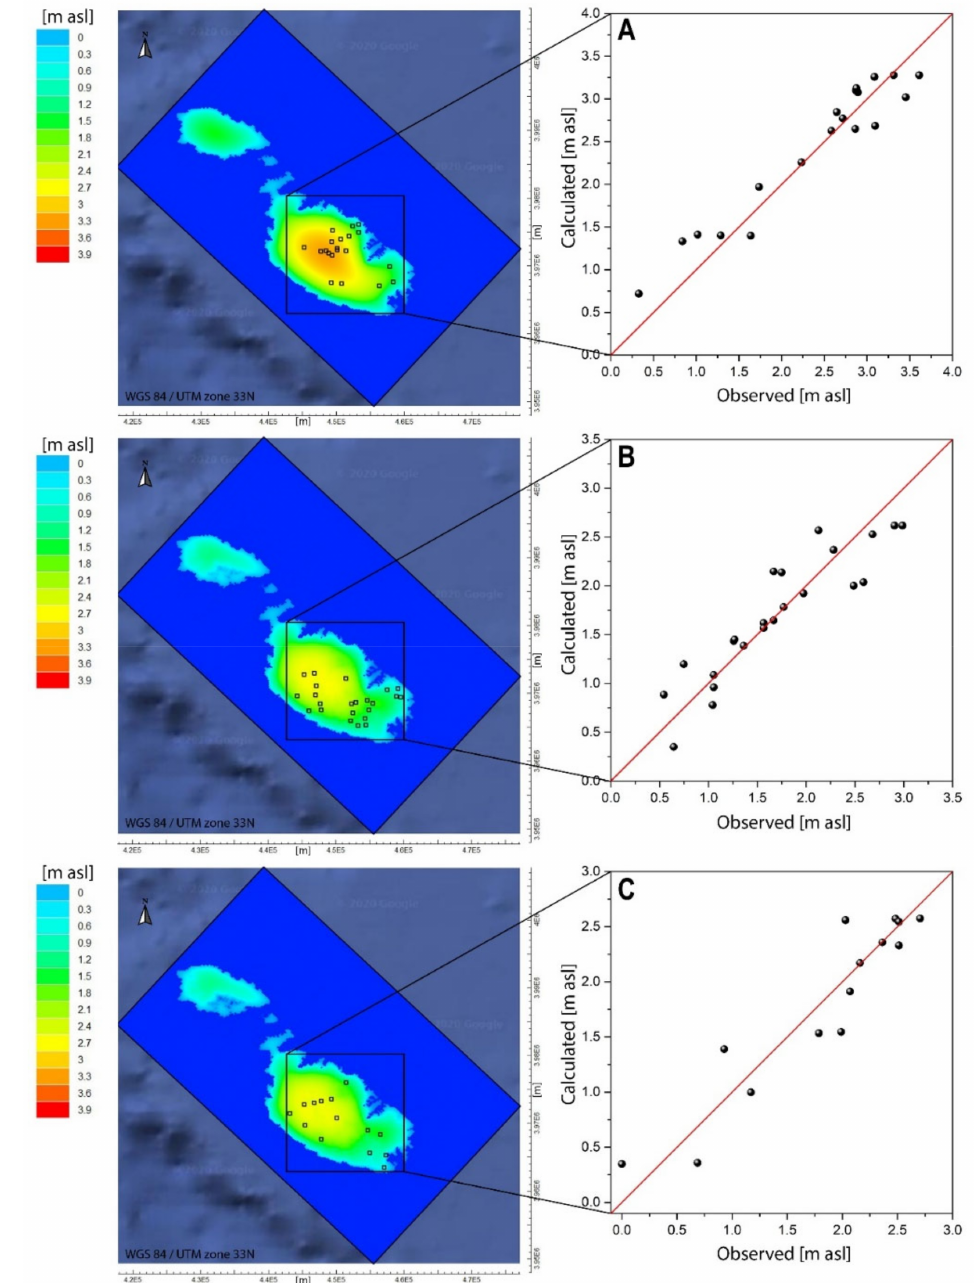
Figure 4. Maps of the hydraulic head distribution with monitoring wells configuration (small squares with a black perimeter) and scatter plots of observed vs. calculated hydraulic head data for ( A ) 1944, ( B ) 1990 and ( C ) 2014